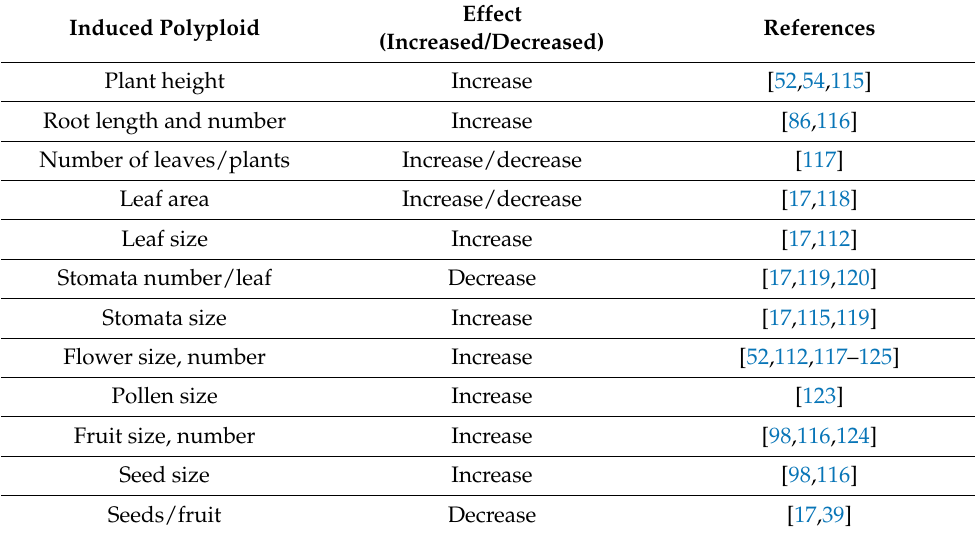
Table 2. Effect of polyploidization on plant morphology and yield attributes.